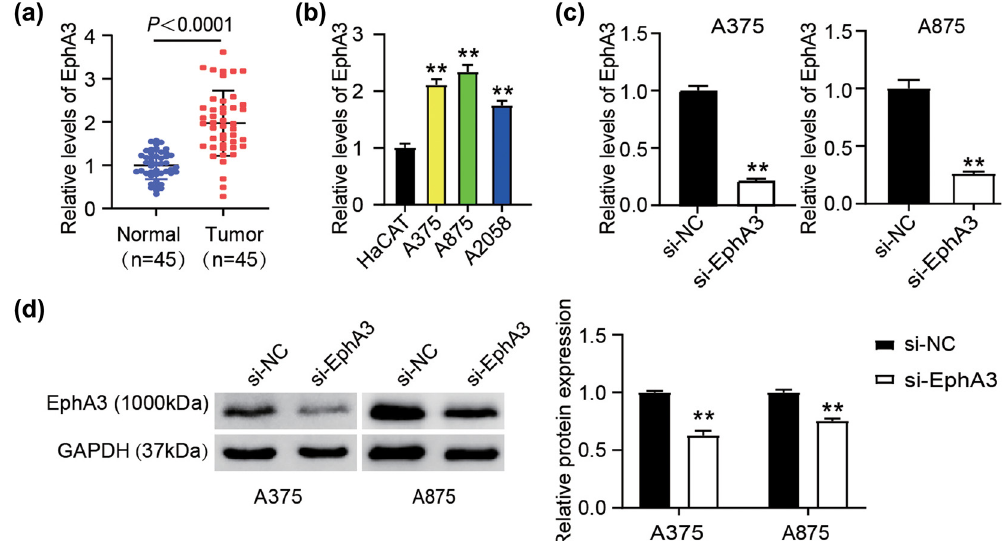
Figure 1: Upregulation of EphA3 in melanoma tissues and cells. ( a ) EphA3 mRNA levels were detected in melanoma tissues and normal tissues by RT - qPCR analysis. ( b ) EphA3 mRNA levels were detected in a pan of melanoma cells ( A375, A875, and A2058 ) and HaCAT cells by RT - qPCR analysis. * P < 0.01 vs HaCAT. ( c ) Si - EphA3 or si - NC was transfected into A375 and A875 cells. Forty - eight hours post - transfection, phA3 mRNA levels were detected in these transfected cells using RT - qPCR analysis. ** P < 0.01 vs si - NC. ( d ) Si - EphA3 or si - NC was transfected into A375 and A875 cells. Forty - eight hours post - transfection, EphA3 proteins were detected in these transfected cells using western blot analysis. ** P < 0.01 vs si -